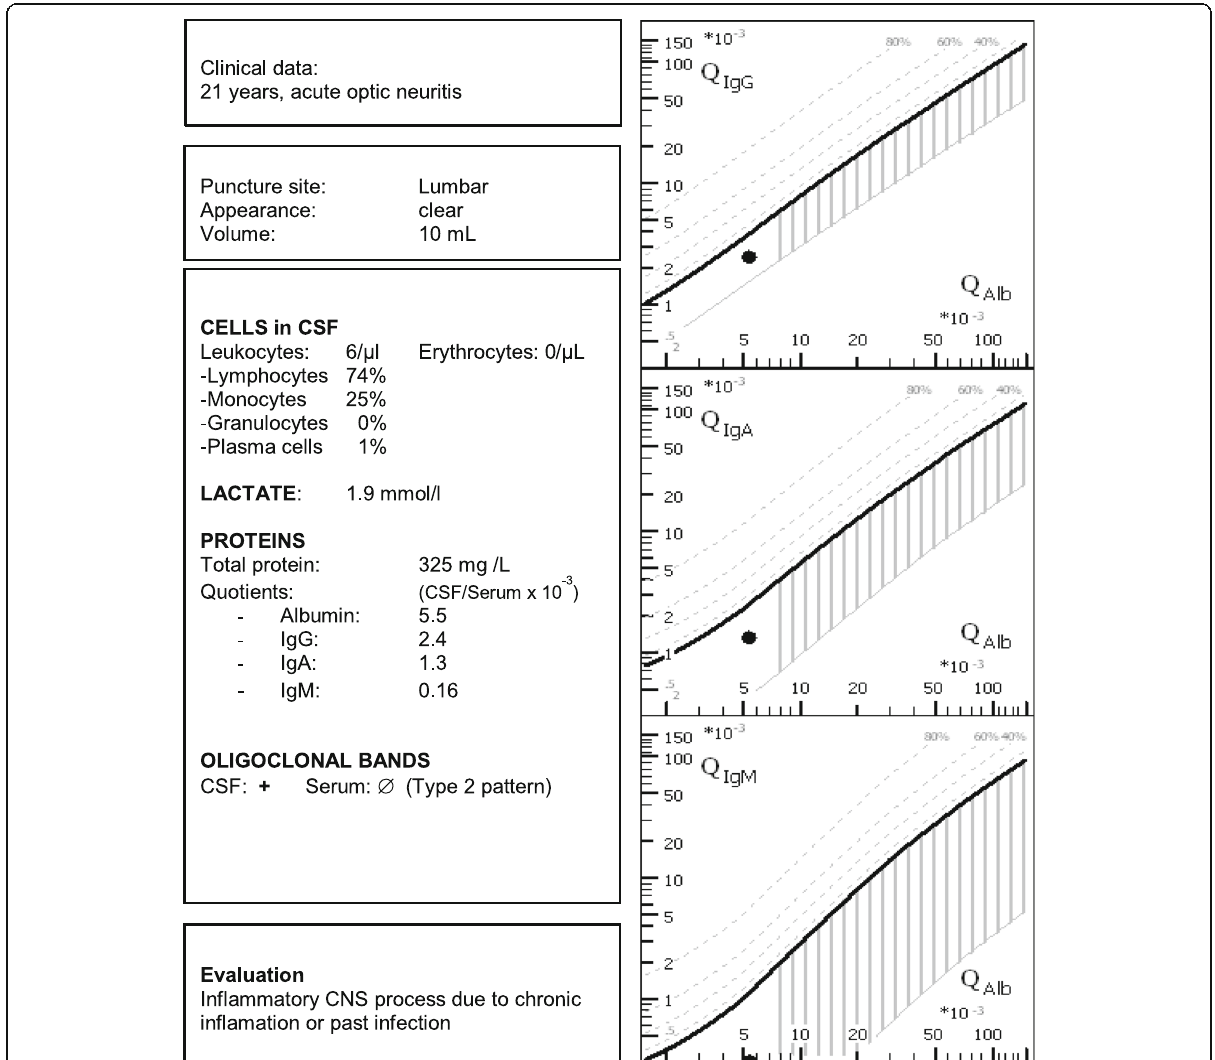
Fig. 1 Example of an integrated total CSF